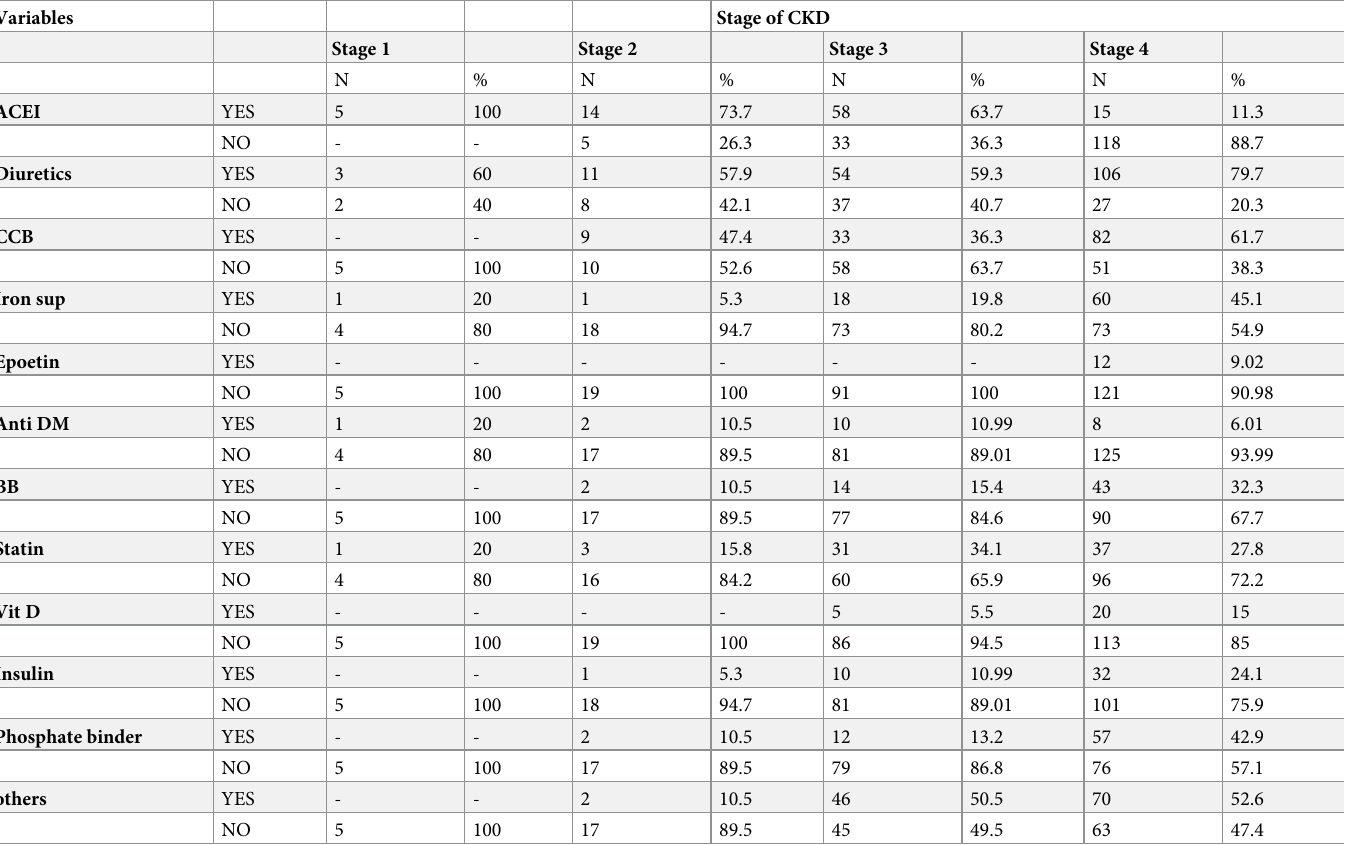
Table 3. Distribution of medication used among patients with CKD at St. Paul’s Hospital Millennium Medical College, Addis Ababa, Ethiopia, June-August, 2019. Variables